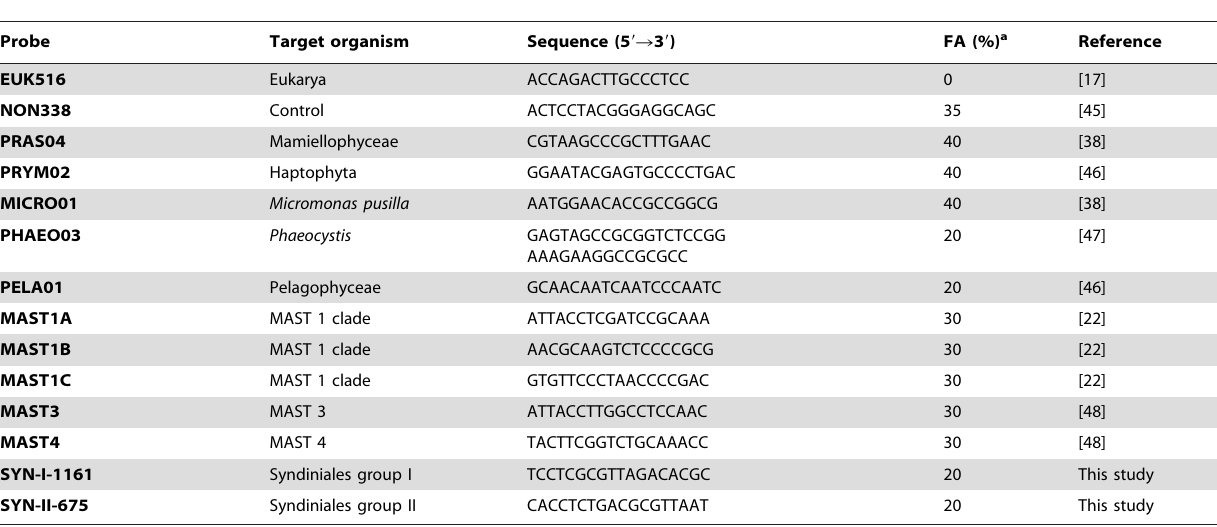
Table 1. List of oligonucleotides used in this